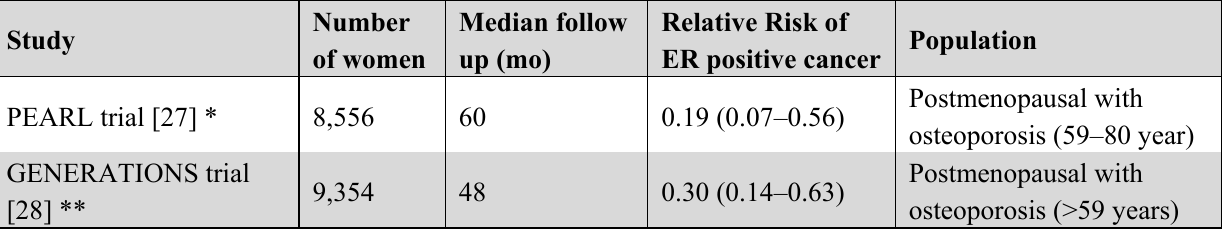
Table 3. Studies on third generation SERMs as a breast cancer preventive